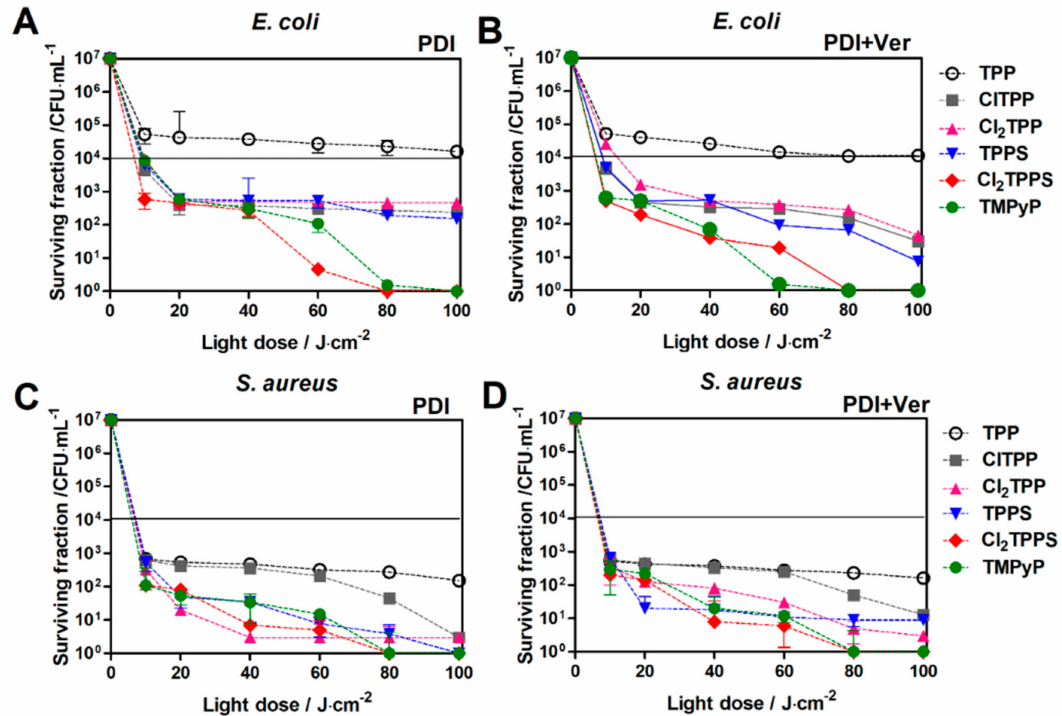
Figure 16. The surviving fraction of bacteria following PDI of E. coli and S. aureus with TPP, ClTPP, Cl 2 TPP, TPPS, Cl 2 TPPS, and TMPyP as the PS without ( A , C ) and with EPI ( B , D ) after 2 h of incubation and application of light doses up to 100 J / cm 2